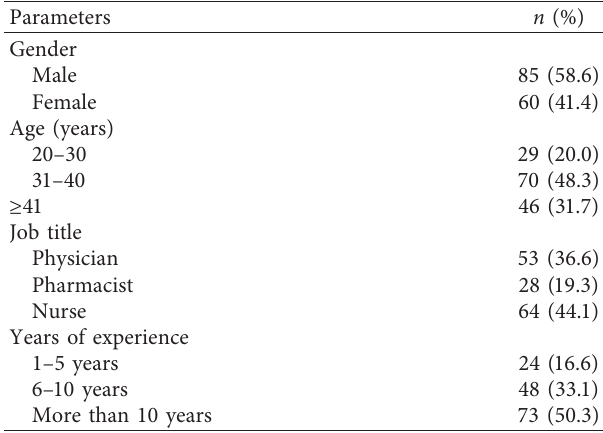
Table 1: Characteristics of the participated healthcare providers ( n �